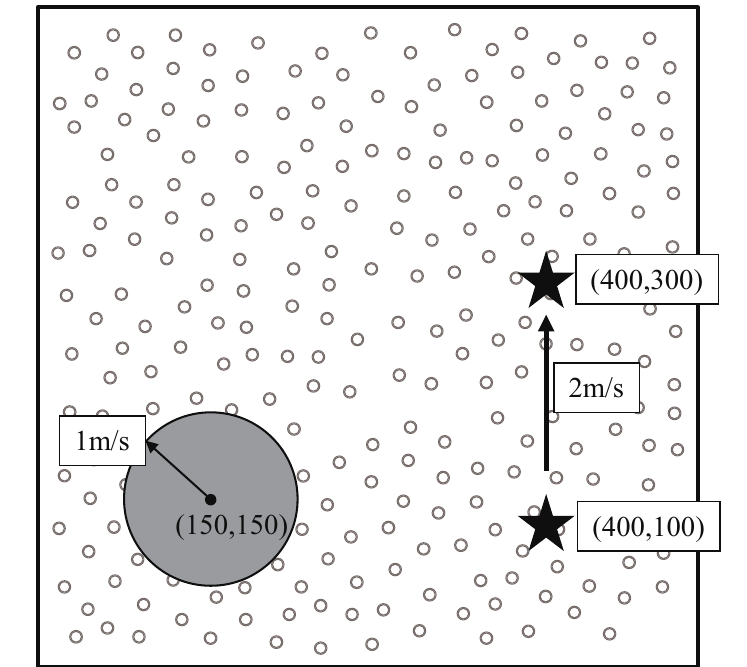
Figure 14. Tracking